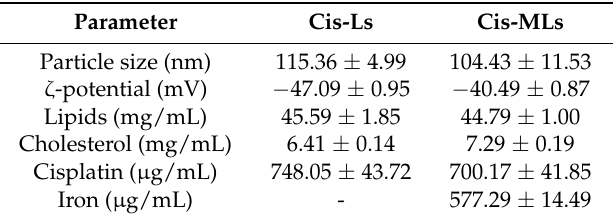
Table 1. Physicochemical characterization of liposomes. Main physicochemical parameters measured immediately after preparation.